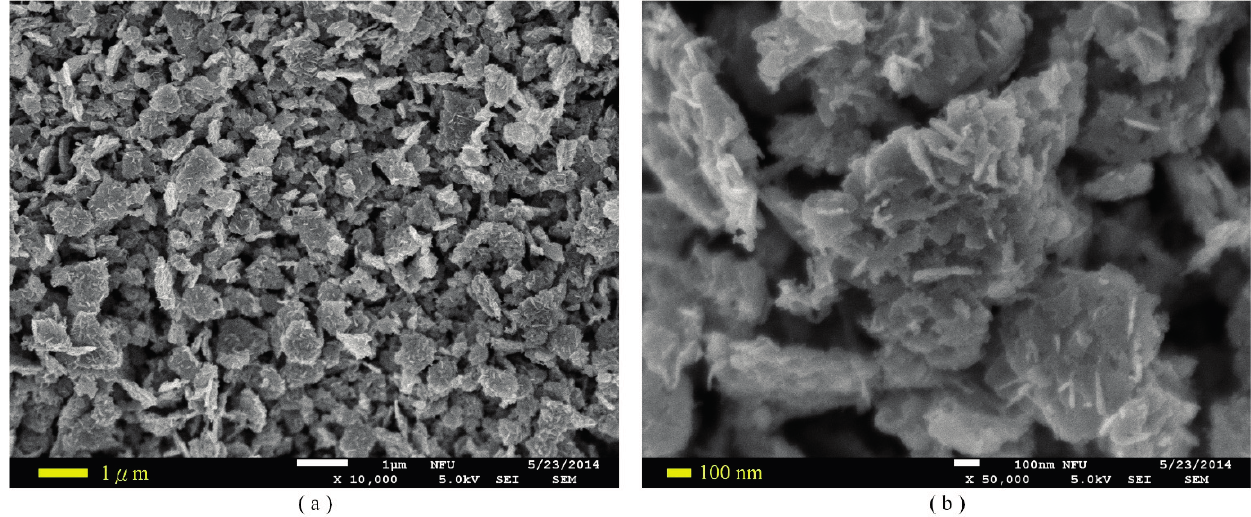
Figure 5. SEM images of the ZnO film deposited by AD with magnification of ( a ) 10,000× and ( b ) 50,000×.